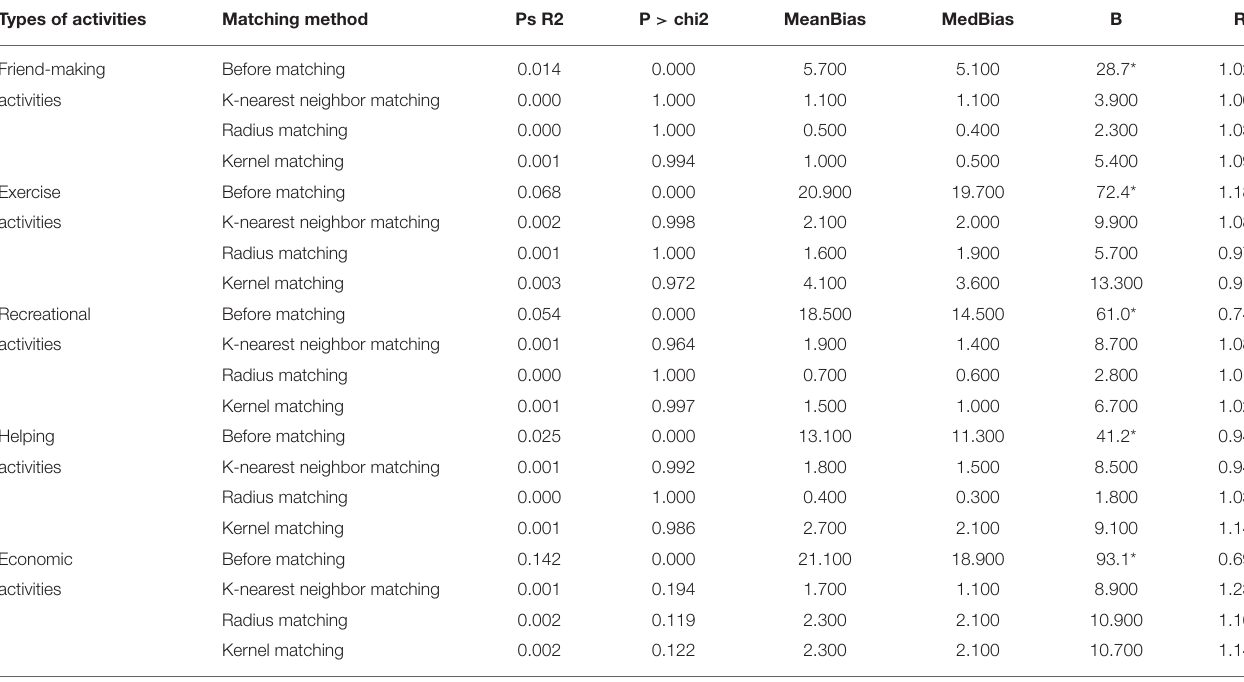
TABLE 6 | Balance test results of covariates before and after propensity score matching. Types of